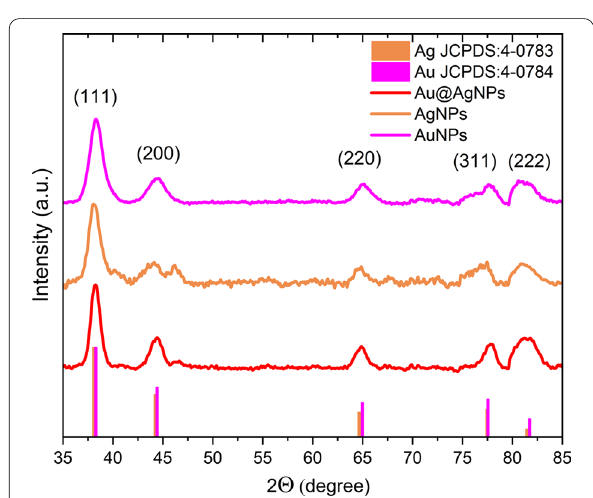
Fig. 8 X‑ray Diffraction AuNPs (pink), AgNPs (brown), and Au@AgNPs